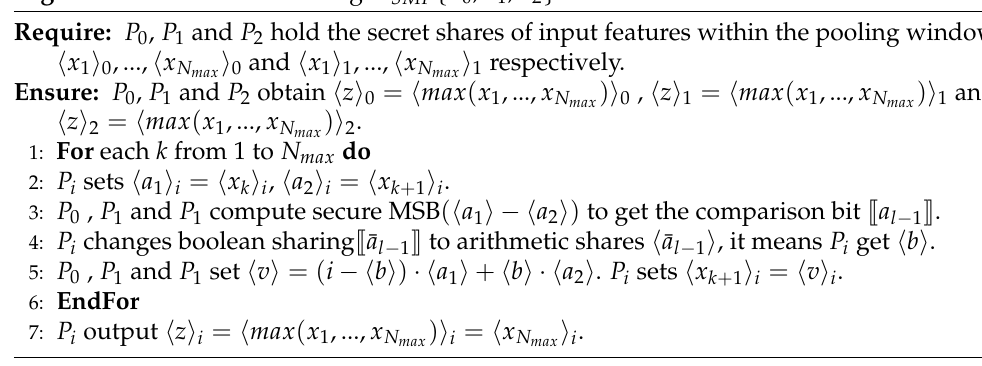
Algorithm 4 SecureMaxPooling Π SMP { P 0 , P 1 , P 2 }